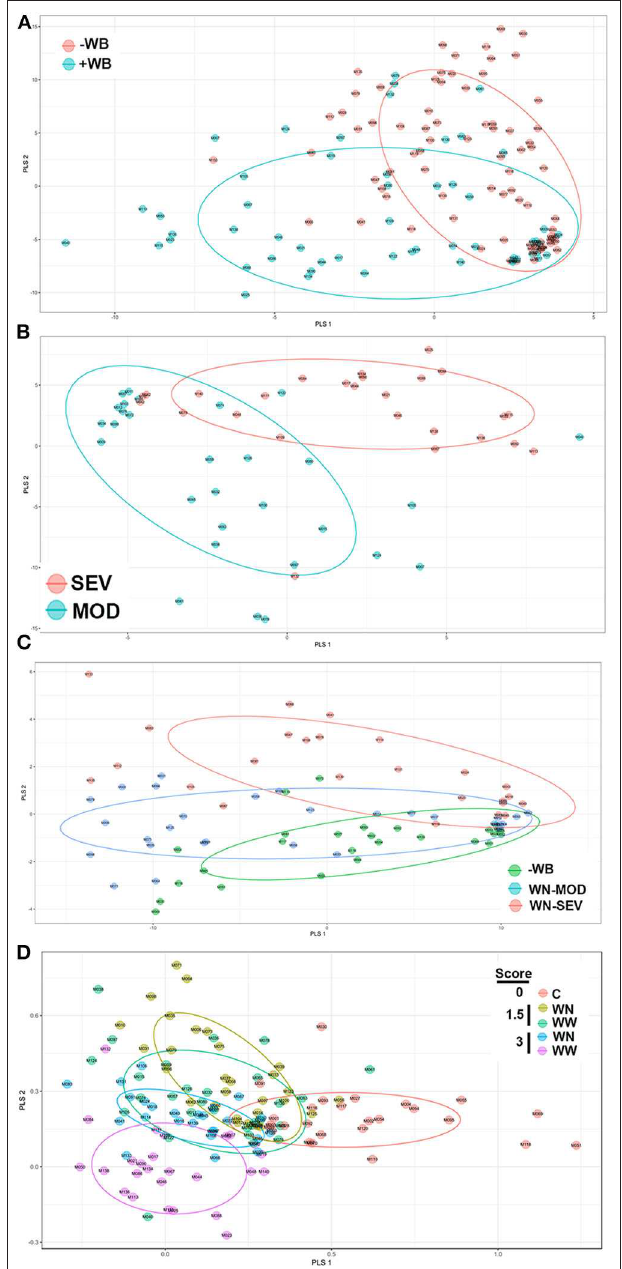
FIGURE 2 | Partial Least Squares Discriminate Analysis (PLS-DA) scores plots. PLS-DA was constructed using the statistical package DiscriMiner in R version 3.6.1 and displayed different clusters when comparing metabolite profiles between WB-affected and unaffected birds (A) , MOD and SEV WB (B) , WN-MOD, and WN-SEV (C) , and all the groups together (D) .